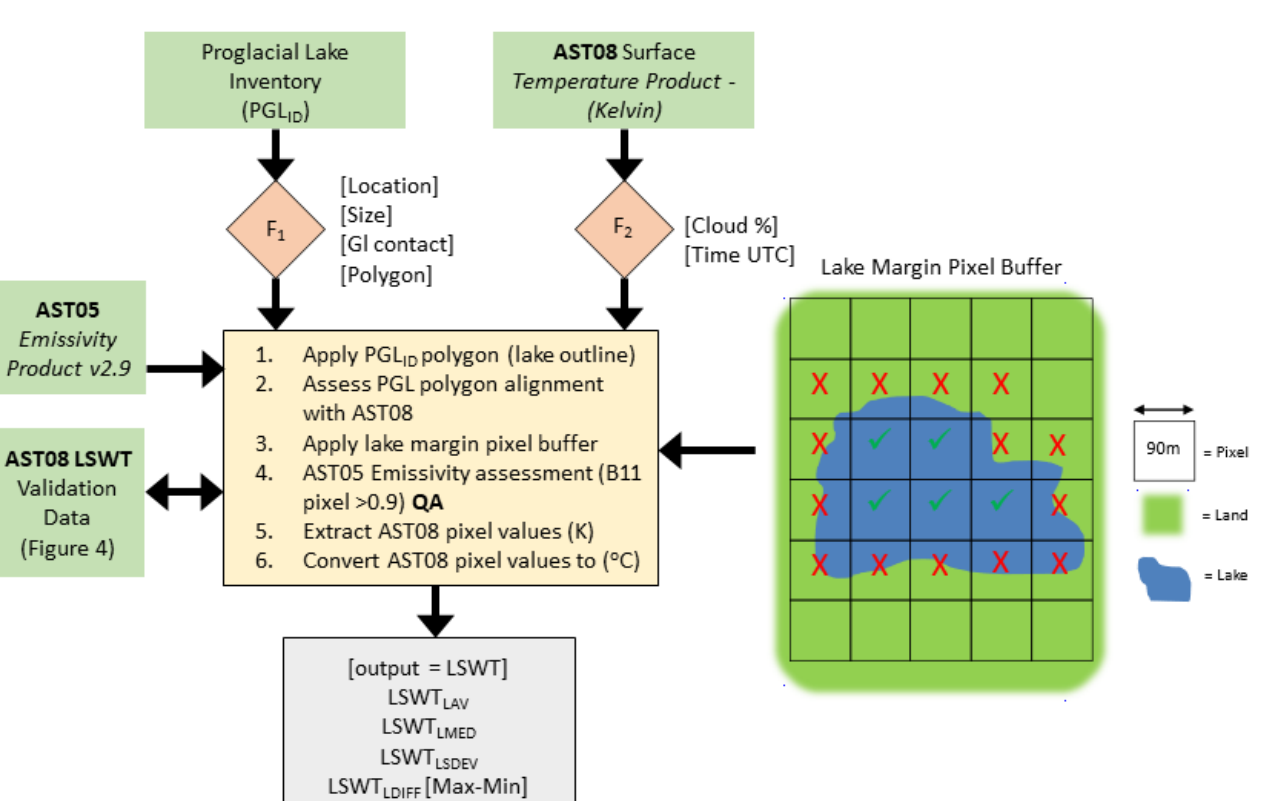
Figure 3. Workflow for extracting surface temperatures (LST) for proglacial lakes (LSWT) from the ASTER surface temperature product (AST08 v2.9) over Arctic Sweden. The proglacial lake inventory (PGL ID ) geometry and characteristics (including associated glacier geometry from the Randolph Glacier Inventory) are used in the analysis. The PGL ID was filtered for lakes >129,600 m 2 (see text) and also by the classification of contact (0 = no contact, 1 = contact with glacier) with glaciers in corresponding ASTER optical imagery. The ASTER emissivity product (AST05) was inspected for quality assessment (QA) of emissivity data used in the production of the AST08 surface temperature product (AST08; see below). A lake margin pixel buffer was used in the selection of AST08 surface temperatures to ensure that temperatures were from water areas. Mixed pixels from around the margins of the lake were not included in the analysis. Data validation is presented in Figure 4.